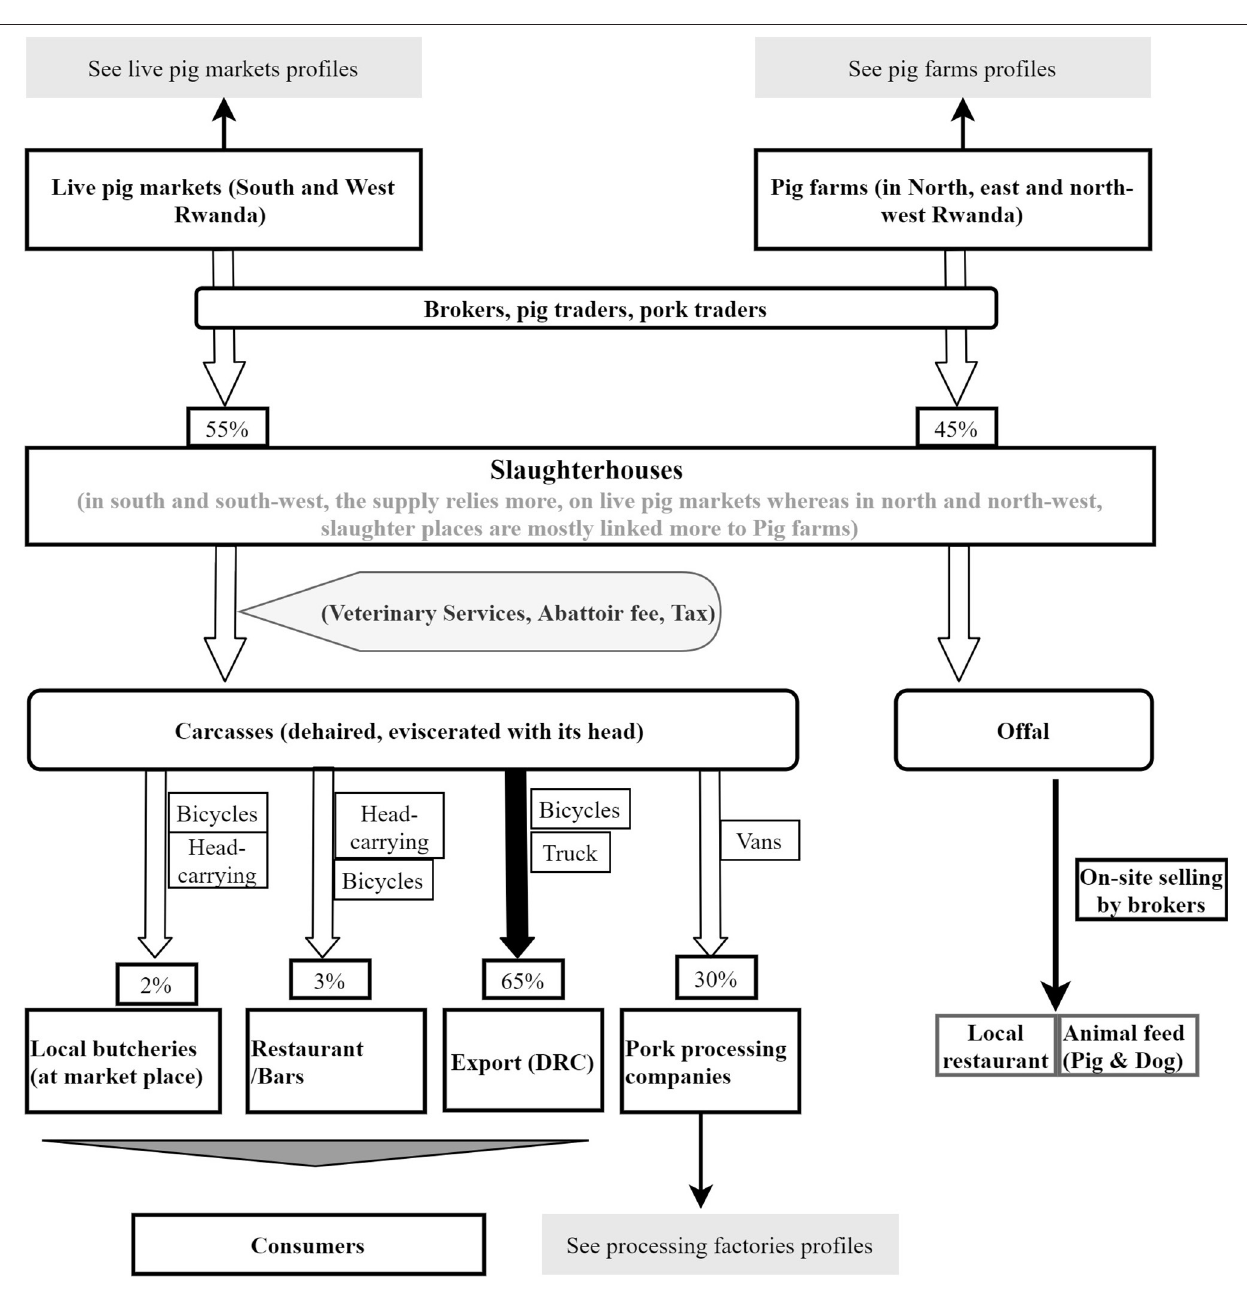
FIGURE 5 | Profile of Rwanda pig slaughter slabs. The flowchart shows sources and destinations of pigs and pig meat. Percentages relate to the volume of pig meat supplied at each segment.